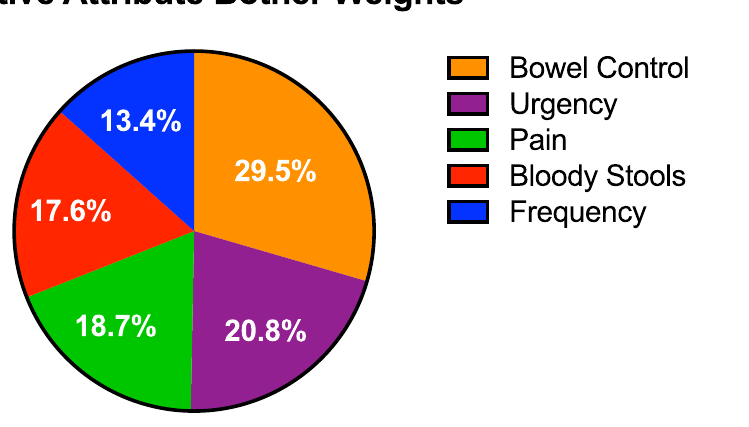
Fig 5. Proposed relative bother weights for